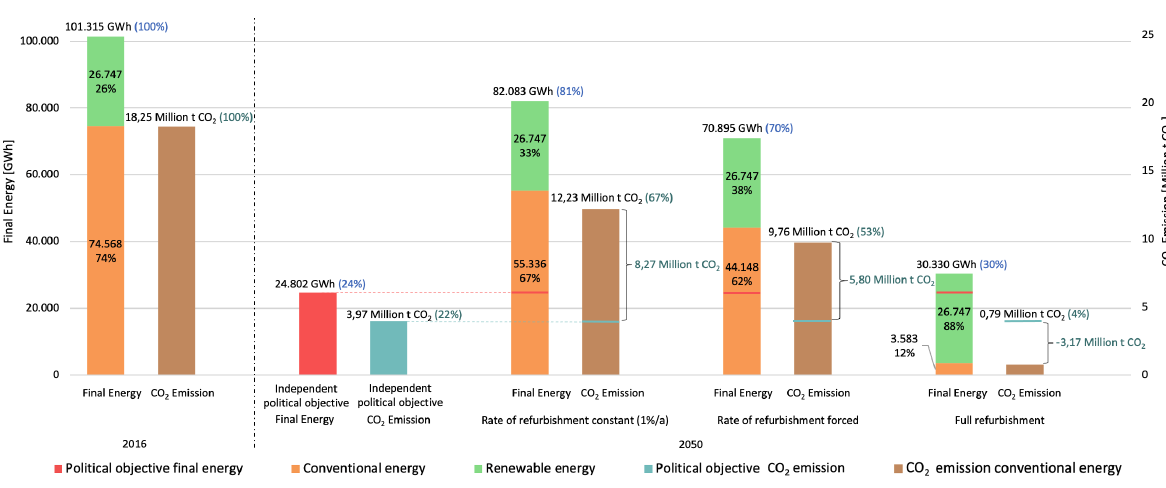
objectives of 3.9 million t CO 2